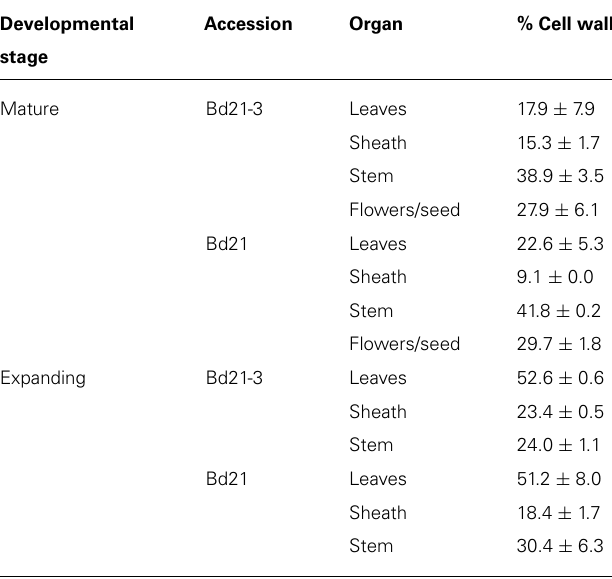
Table 7 | Relative contribution of cell wall material per aerial